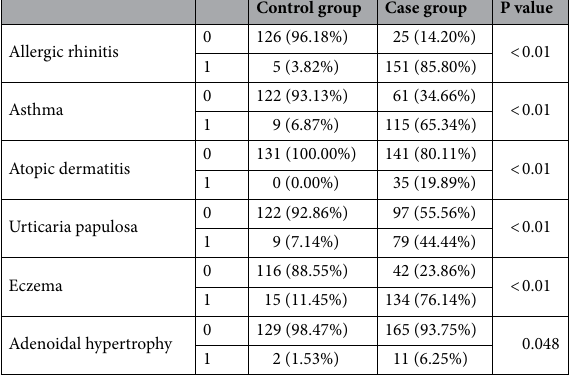
Table 3. The subjects with other concomitant diseases in two groups. 0 means without this disease. 1 means with this disease.